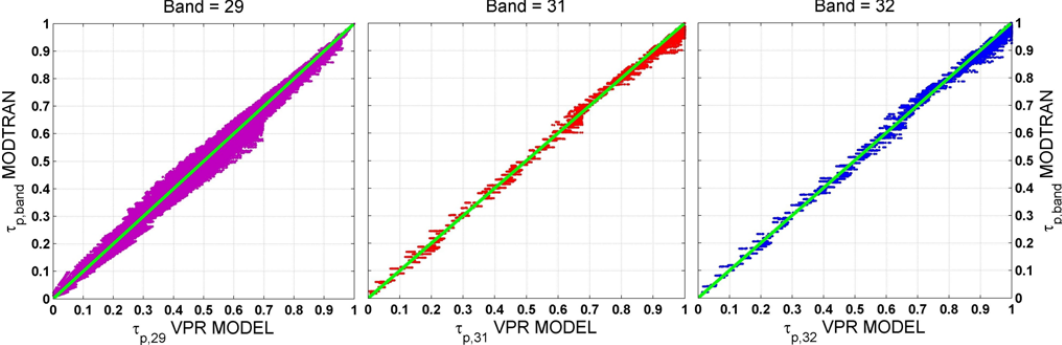
Fig. 3. From left to right: scatter plots of the MODTRAN simulated plume transmittances versus those computed using the procedure described, for channels 29, 31, and 32, respectively. The thick straight line represents a slope of unity. The r 2 correlation coefficients are, respectively, 0.9954, 0.9988, and